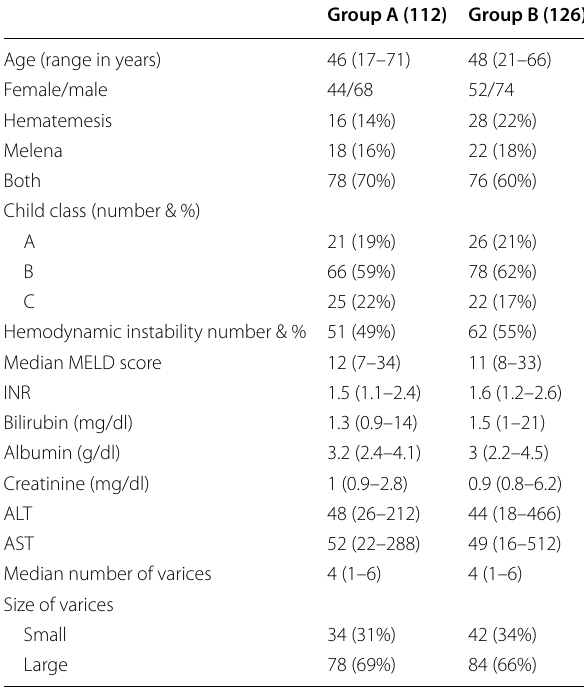
Table 1 The baseline characters of the studied groups